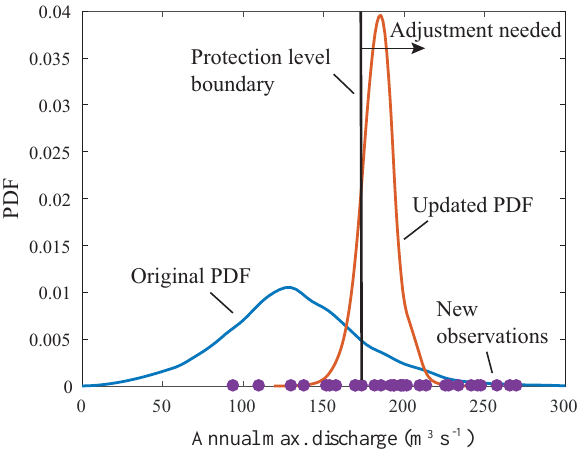
Figure 4. Original and updated PDF based on a period of high new observations of annual maximum discharge. Because the original PDF is so broad, the period of extreme observations results in a strongly shifted updated PDF, the peak of which (corresponding to the estimate of q ( 1 ) ) crosses the protection boundary level. Thus, the protection system must be